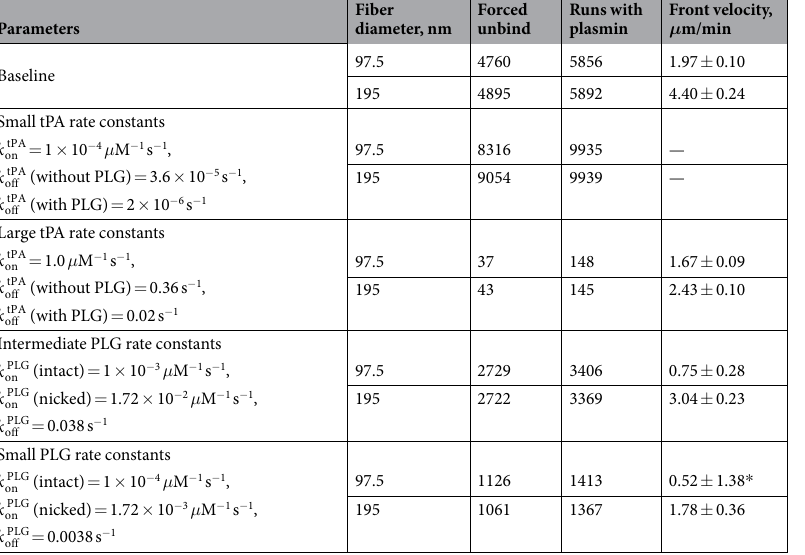
Table 2. Model results for varying binding and unbinding rate constants. “Baseline” corresponds to parameter values in Table 1, and other parameter values differ from baseline values only as indicated. The column labeled “Forced unbind” gives the number of runs out of 10,000 microscale simulation runs for which tPA was forced to unbind by plasmin. The column labeled “Runs with plasmin” gives the number of microscale runs, out of 10,000, in which plasmin was produced and single fiber lysis occurred. For the macroscale model results (“Front velocity”), the experiments involved a 5 nM tPA concentration added to a fibrin-free region with height 2.935 μ m. Entries are mean ± standard deviation of 10 independent simulations. Front velocity calculations do not make sense for simulations in which lysis was not front-like, hence the “ − ” in some entries. An asterisk indicates a case in which lysis is front-like (tPA strongly binds to the front), but so slow that it is computationally challenging to measure front